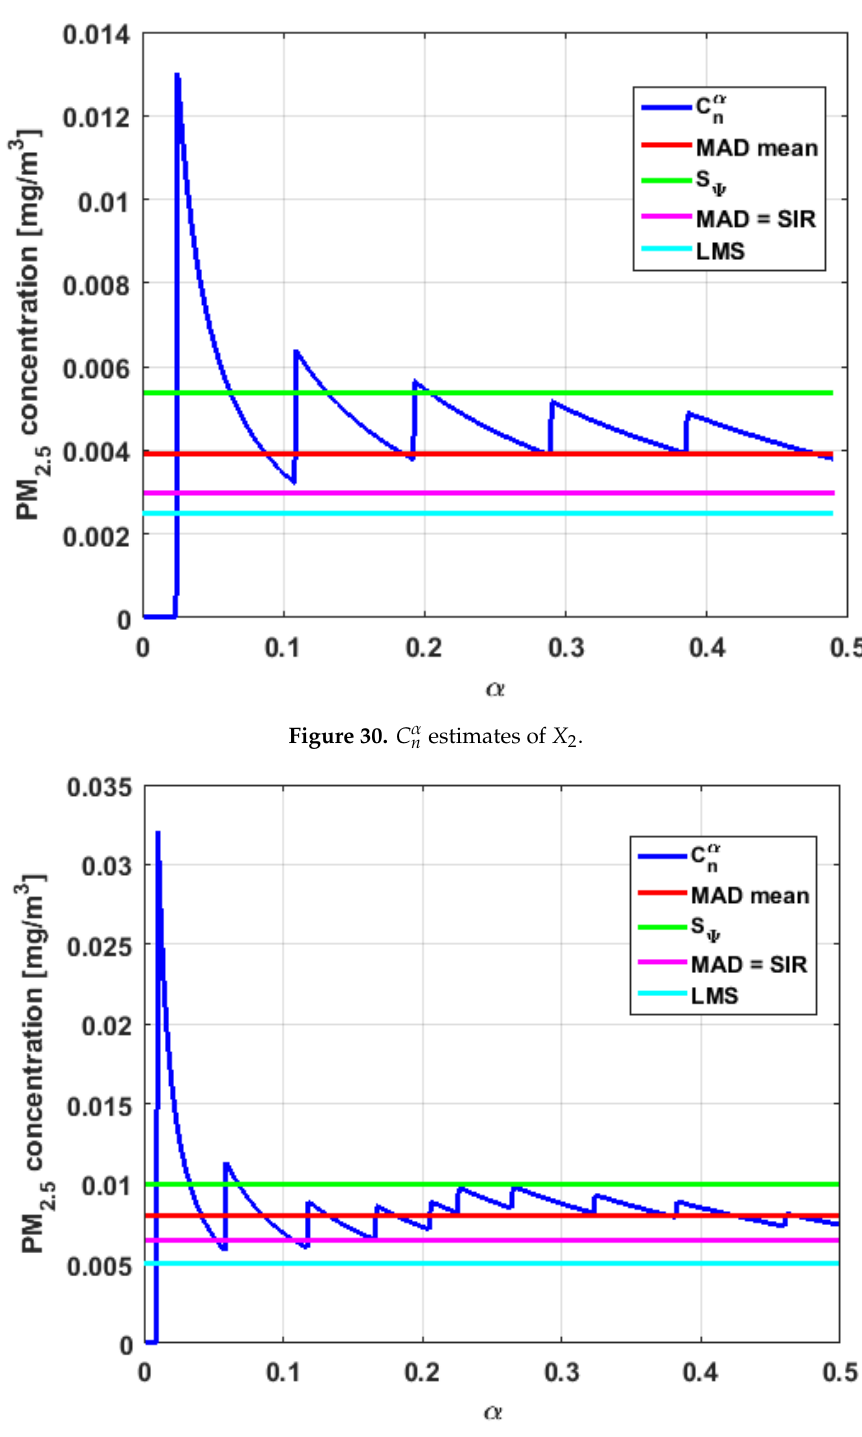
Figure 31. 𝐶 𝑛𝛼 estimates of 𝑋 3 . Figure 31. C α n estimates of X 3